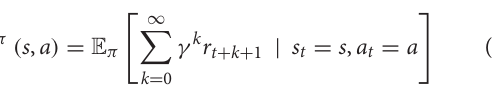
new state s ′ after acting action a and keeps using policy π from the state s ′ to the end of the decision